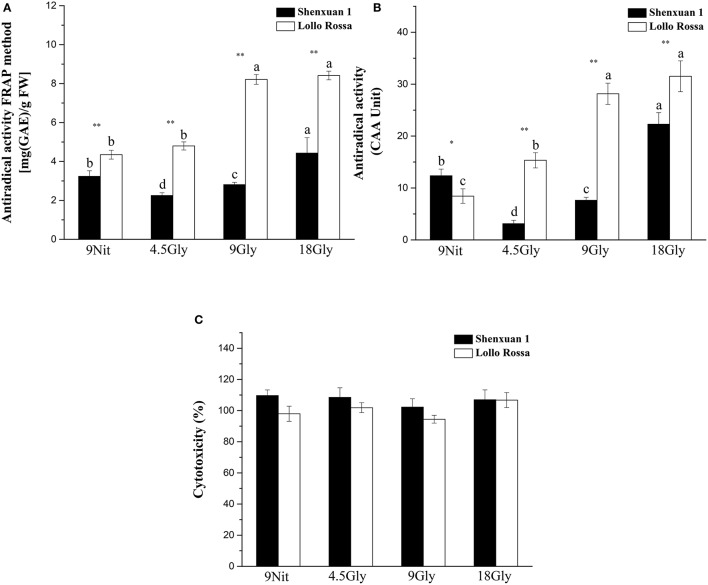
Effect of glycine or nitrate supply on the antioxidant activity of lettuce leaf extracts. (A) FRAP assay. (B) CAA assay. (C) Cytotoxicity assay. Different small letters indicate significant differences, p < 0.05; LSD analysis (n = 3). The “*” (p < 0.05) and “**” (p < 0.01) indicate significant differences between cultivars (t-test).